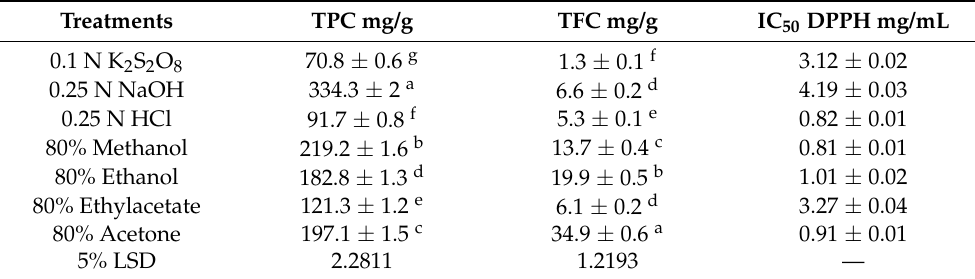
TPC, TFC, and antioxidant activities of extracted Moringa oleifera leaves with different